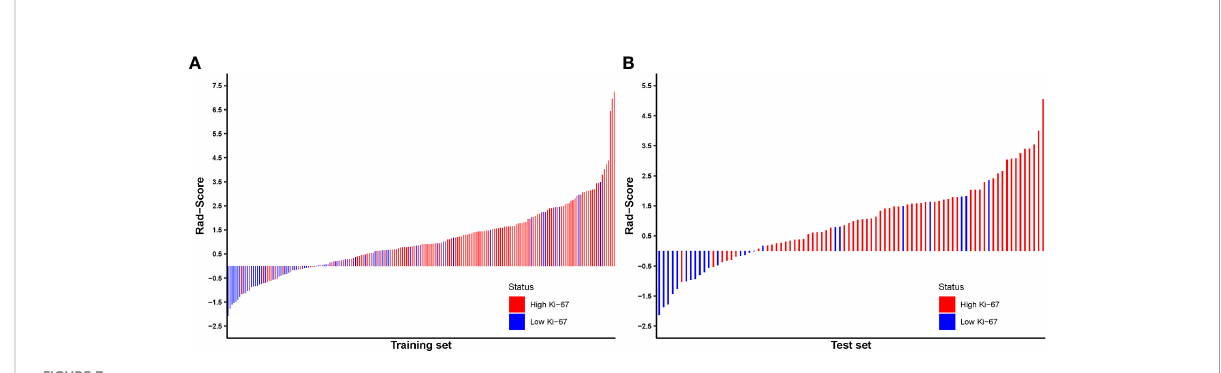
FIGURE 7 Radiomics score for each breast carcinoma patient in the training (A) and test sets (B)